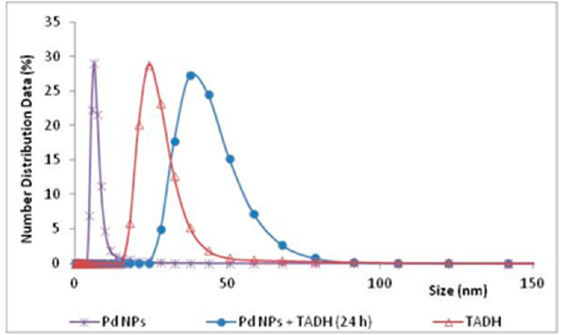
Figure 5. Dynamic light scattering (DLS) spectra of diluted solution of Pd NPs (8 nm), phosphate-buffer-diluted solution TADH (24 nm) and diluted solution Pd NPs after a 24 h incubation period with TADH (38 nm).